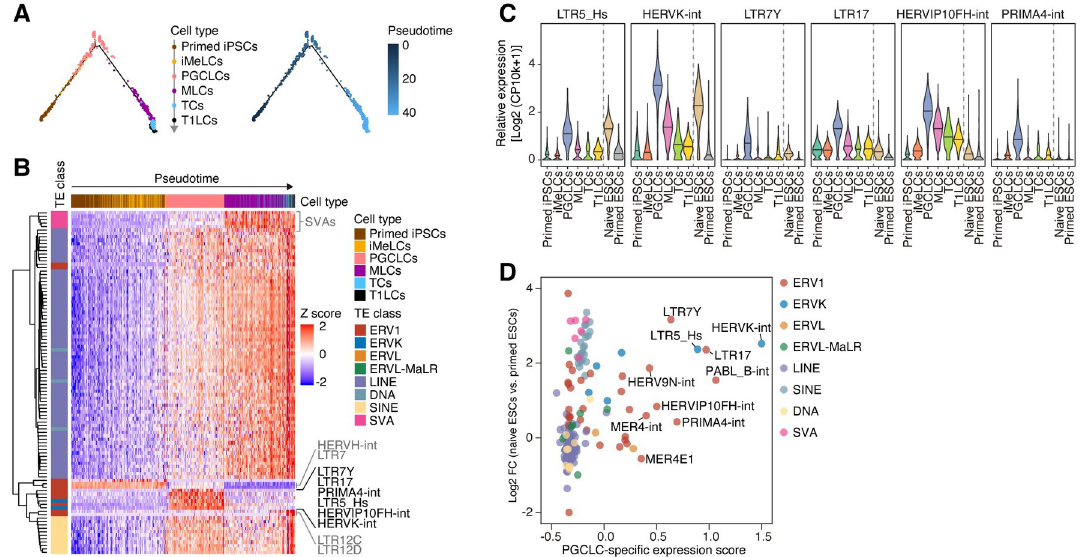
Fig 2. Specific expression of HERVK/LTR5_Hs in PGCLCs and na ï ve ESCs. (A) Pseudotime analysis [41] of scRNA-Seq data for in vitro -derived human male germline development [Hwang et al. [10]]. The 1,000 protein-coding genes that were the most differentially expressed throughout the development process were used. (B) Expression dynamics of TE subfamilies throughout male germline development. The cells are ordered according to the pseudotime shown in ( A ). The 100 TEs that were most differentially expressed among cell types are shown. (C) ERV subfamilies that were specifically expressed in PGCLCs [annotated in ( B ) in black]. In addition to the data for male germline development, data for na ï ve and primed ESCs [Messmer et al. [36]] are shown. (D) Identification of the TE subfamilies that were specifically upregulated in both PGCLCs and na ï ve ESCs. The X-axis indicates the PGCLC-specific expression score (defined in Fig 1B ). The Y-axis indicates the log2 FC of the expression score between na ï ve ESCs vs. primed ESCs. The names of the top 10% TEs with respect to the PGCLC-specific expression score are annotated.